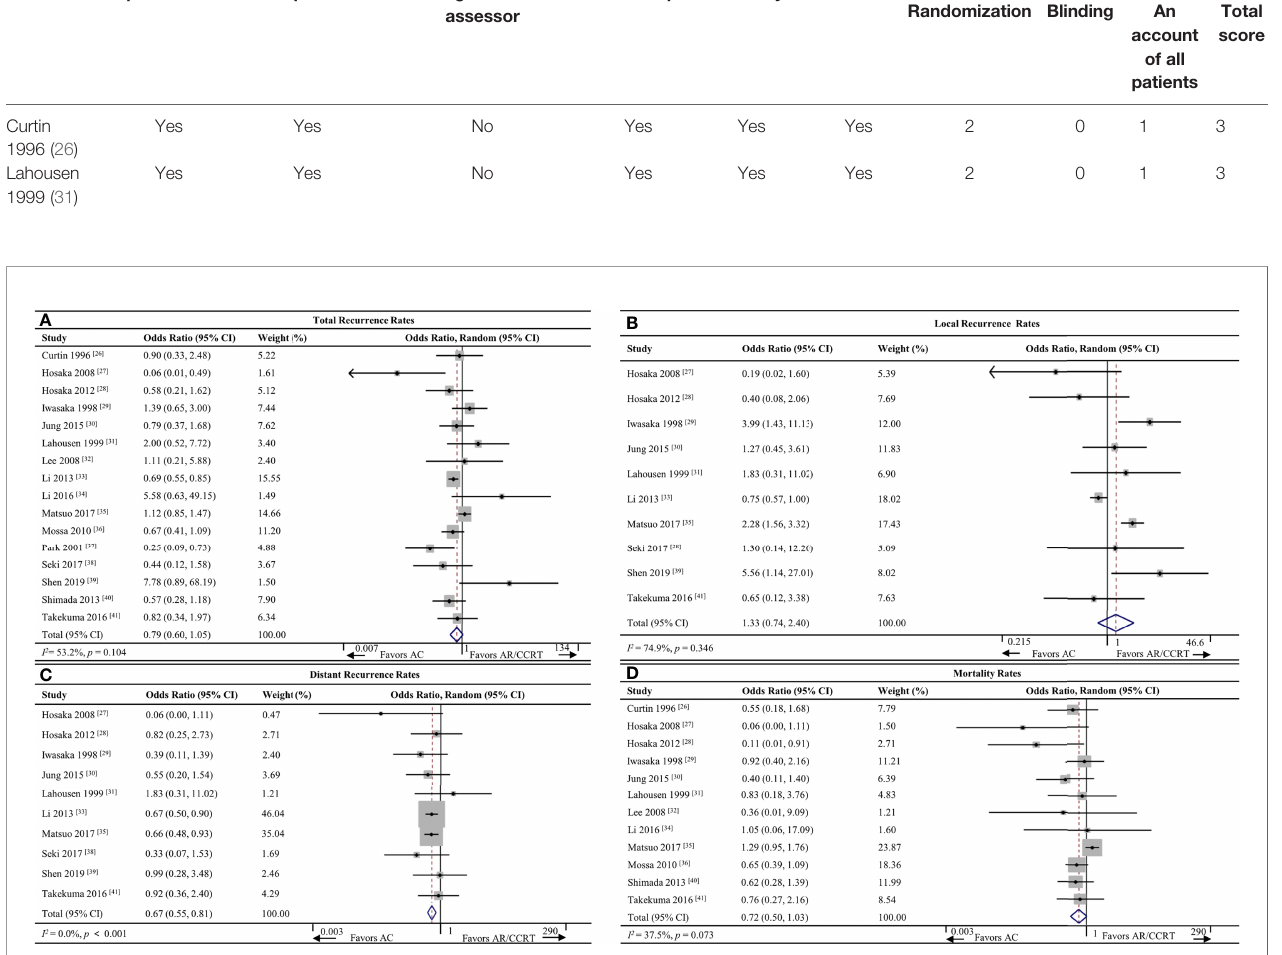
FIGURE 2 | Forest plot of the meta-analysis of (A) total recurrence rates, (B) local recurrence rates, (C) distant recurrence rates or (D) mortality rates in AC and AR/ CCRT groups. AC, adjuvant chemotherapy; AR, adjuvant radiotherapy; CCRT, concurrent chemoradiotherapy; CI, con fi dence interval.